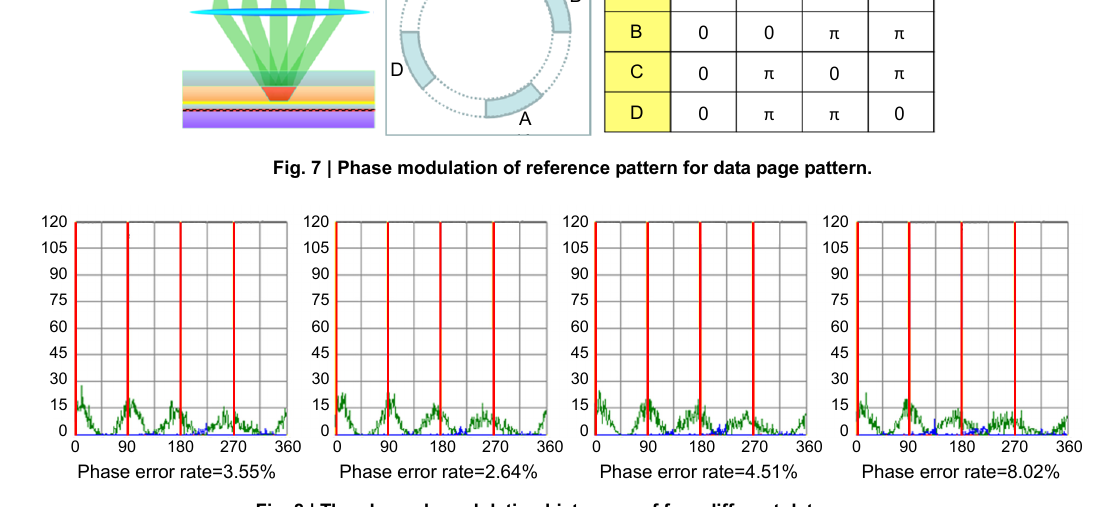
Fig. 8 | The phase demodulation histogram of four different data pages.